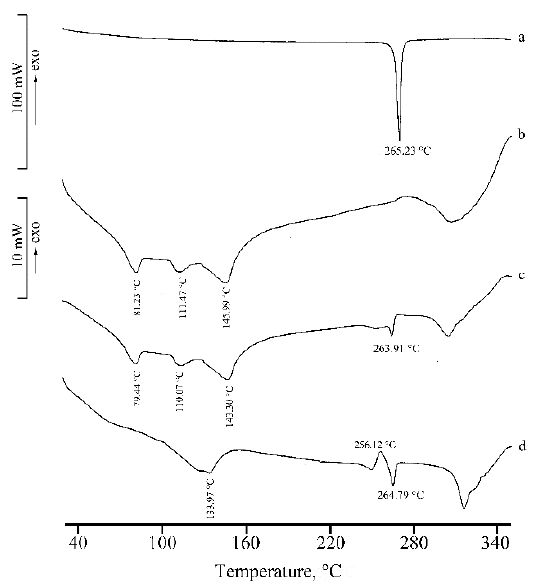
Figure 4. DSC curves of RSV ( a ), α -CD ( b ), their PM ( c ), and KN product ( d ).